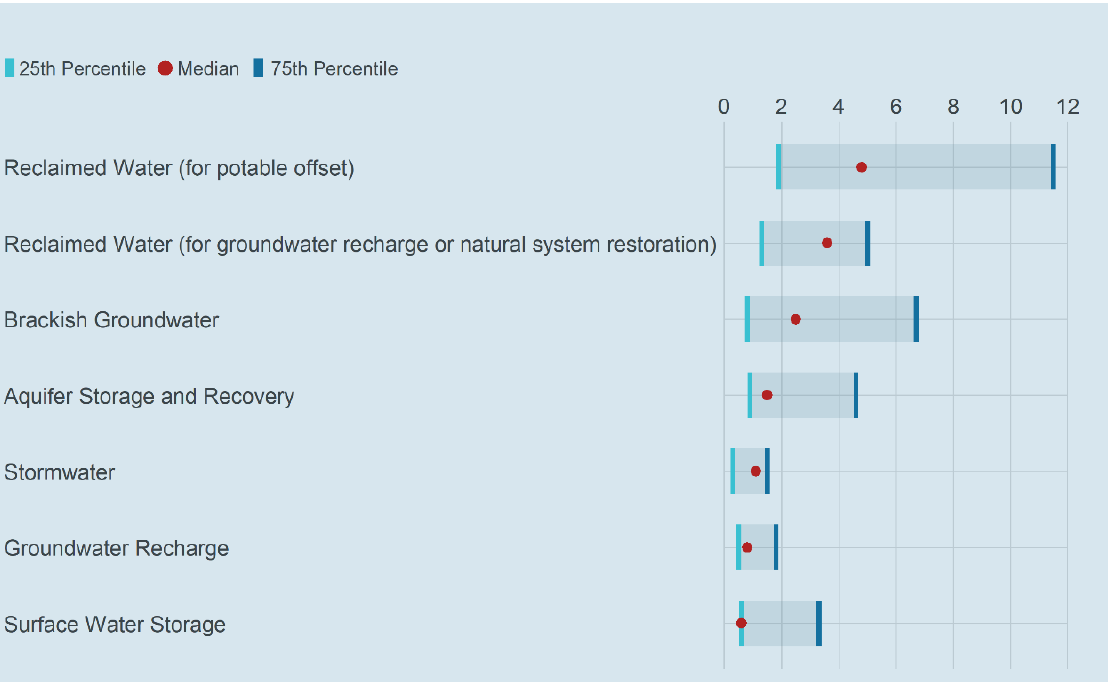
Figure 5. Estimated Project Expenditures per Annual Unit of Capacity for Alternative Water Supply